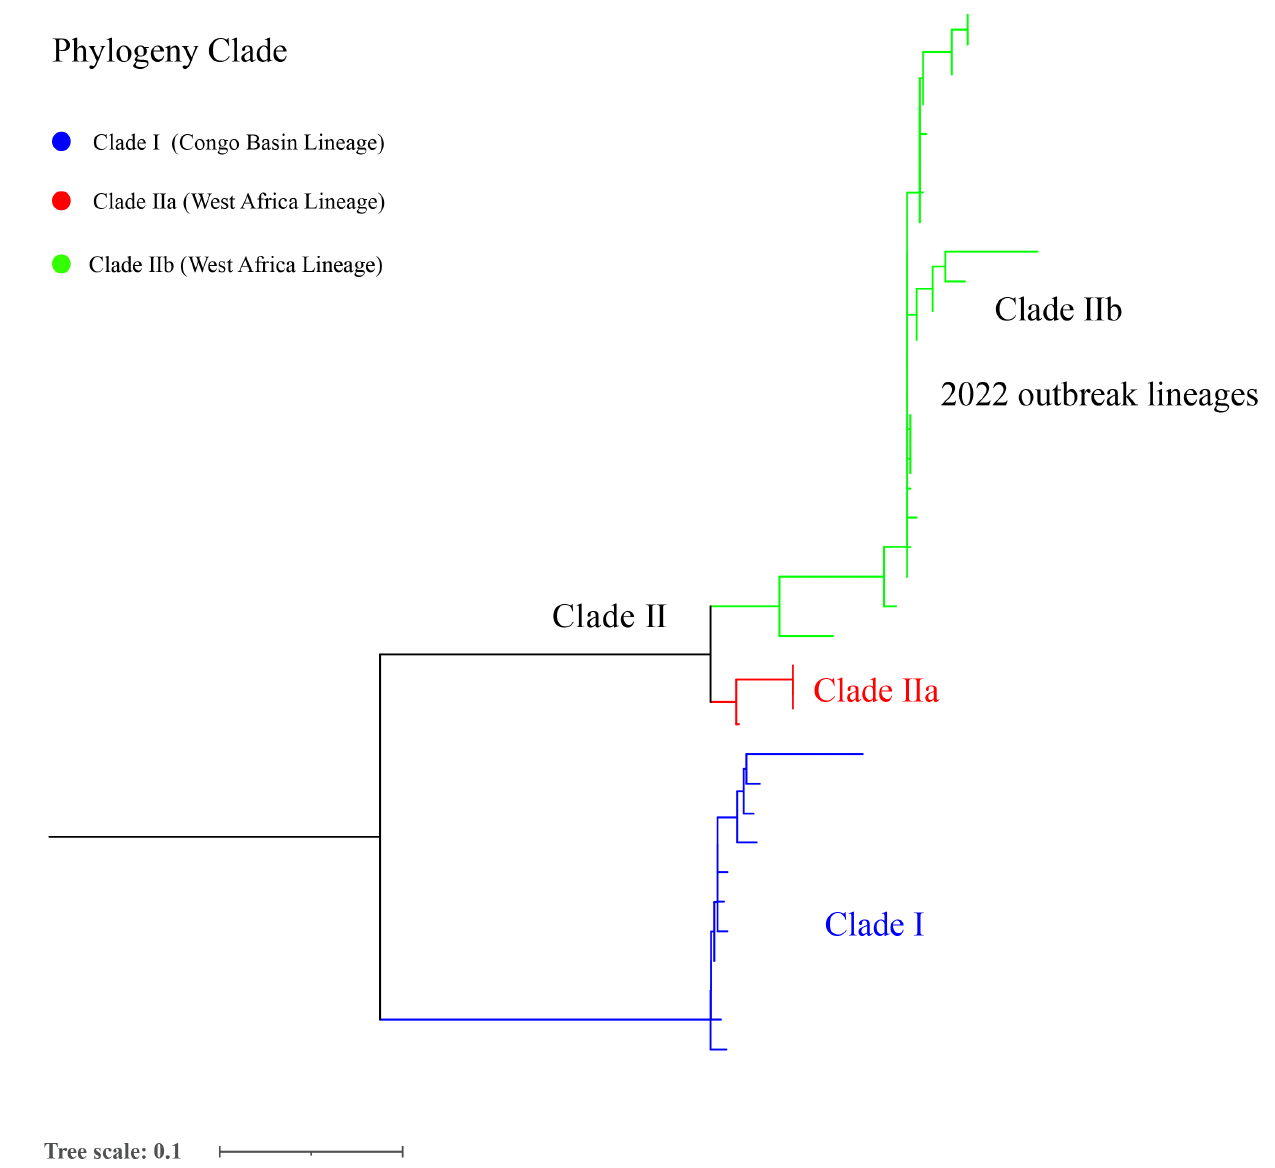
Figure 3. Phylogenetic analysis of 175 MPXV selected genomes from a global level.